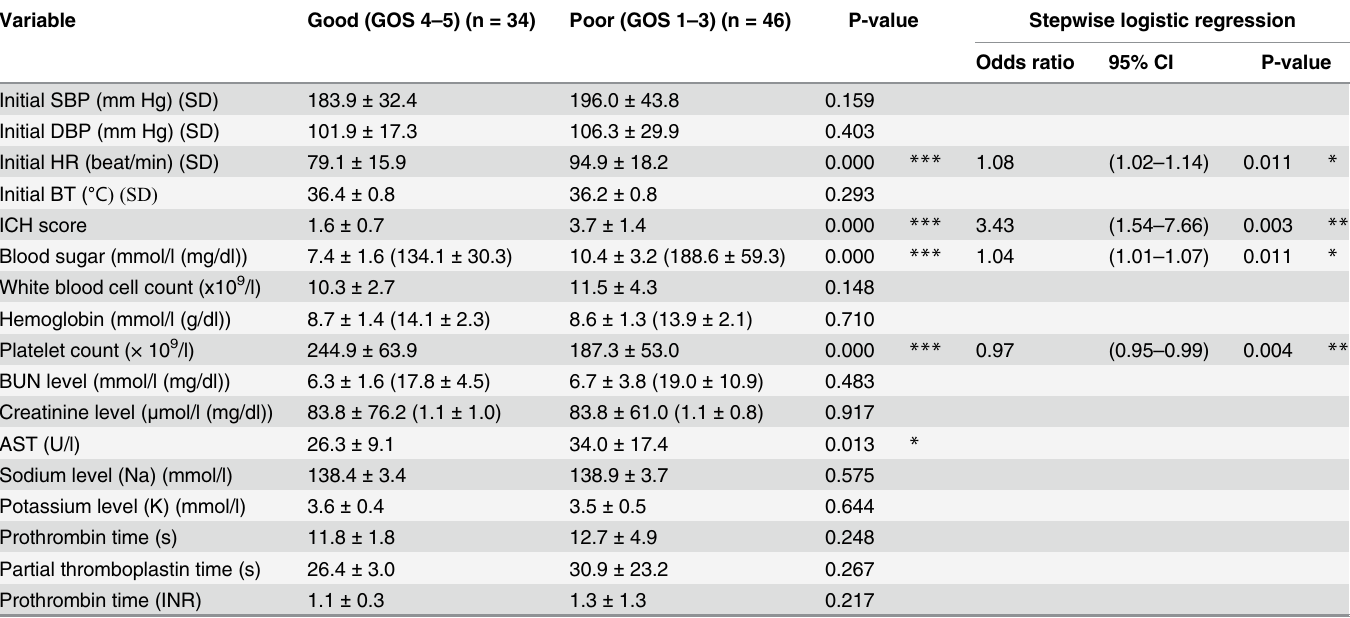
Table 3. The stepwise logistic regression analysis of the study population and the potential factors affecting early outcome at discharge.